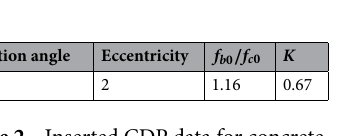
Table 2. Inserted CDP data for